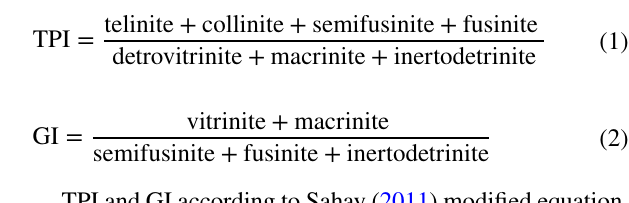
Silva and Kalkreuth (2005), Sahay (2011), and Stock et al. (2016). The TPI and GI values were calculated using the formulae expressed by Diessel (1986) in Eqs. (1) and (2) and were further modified by Silva and Kalkreuth (2005). Sahay (2011) modified the indices to include liptinite as expressed in Eqs. (3) and (4). Calder et al. (1991) considered the groundwater, vegeta- tion, and wood indexes as expressed in Eqs. (5), (6), and (7); while Stock et al. (2016) included the ash yield divided by 2 as expressed in Eqs. (8) and (9) used by Zieger and Littke (2019). Stock et al. (2016) modified the GWI equation of Calder et al. (1991) by considering the ash yield divided by 2 as seen in Eq. (8).